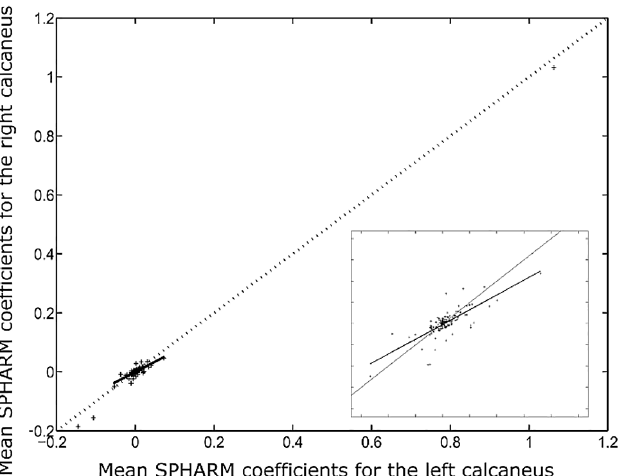
Fig 5. Correlation between the SPHARM coefficients of the left and the right calcaneus. Linear correlation is performed on the reduced set of coefficients excluding the three highest coefficients (see inset).